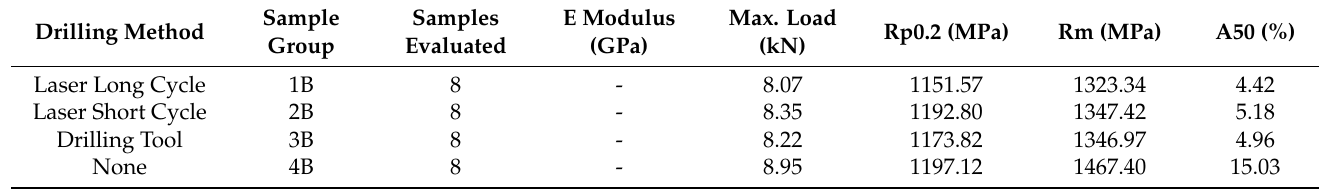
Table 7. Average values of mechanical properties—Inconel 718; material thickness 1.0 mm; tests at room temperature.